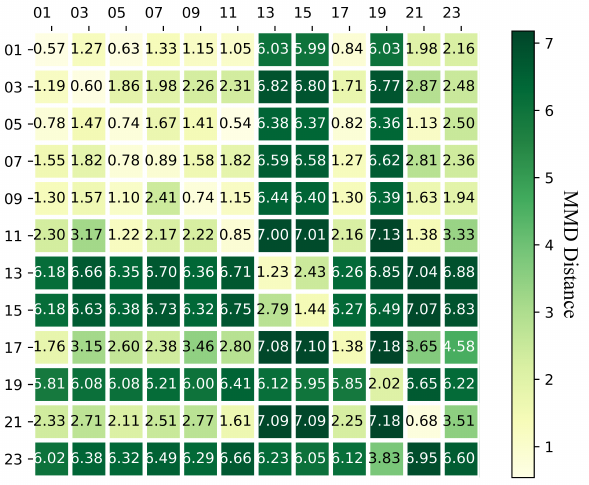
Figure 5. MMD distance of data samples at the same or different